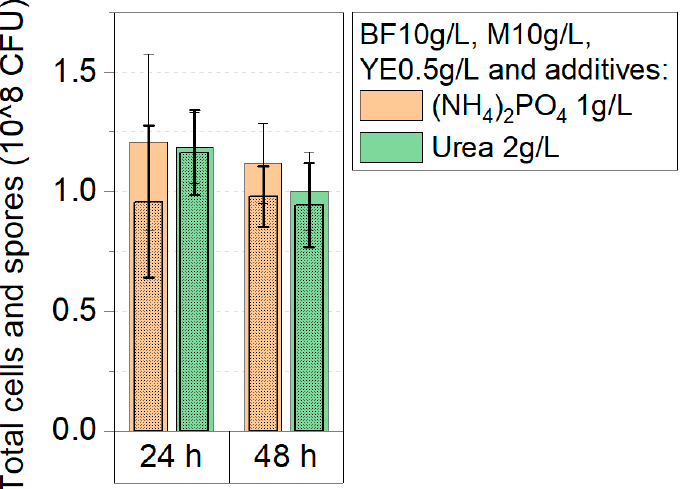
Figure 3. B. subtilis MSCL 897 cultivation in medium containing broad bean flour (BF) 10 g/L, mo- lasses (M) 10 g/L, yeast extract (YE) 0.5 g/L and combinations of (NH 3 ) 2 HPO 4 and urea. Total cell molasses (M) 10 g/L, yeast extract (YE) 0.5 g/L and combinations of (NH 4 ) 2 HPO 4 and urea. Total (outer bars) and spore (inner bars) counts at 24 and 48 h. cell (outer bars) and spore (inner bars) counts at 24 and 48